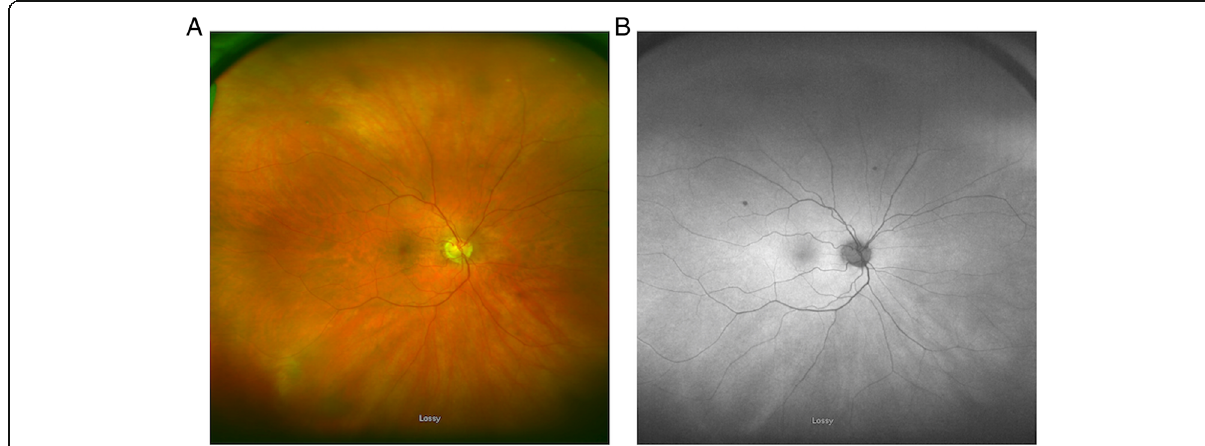
Fig. 2 Fundus photography of patient with npAIR (patient 10). a Fundus photography demonstrating mild optic head nerve pallor, attenuated